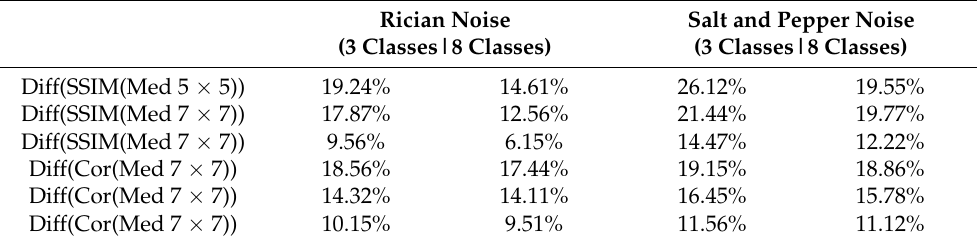
Table 6. A comparison of the regional segmentation performance for two different settings of regions (segmentation classes) in application of median and optimized RNLM filter under influence of Rician and Salt and Pepper noise. Rician Noise Salt and Pepper Noise (3 Classes|8 Classes) (3 Classes|8